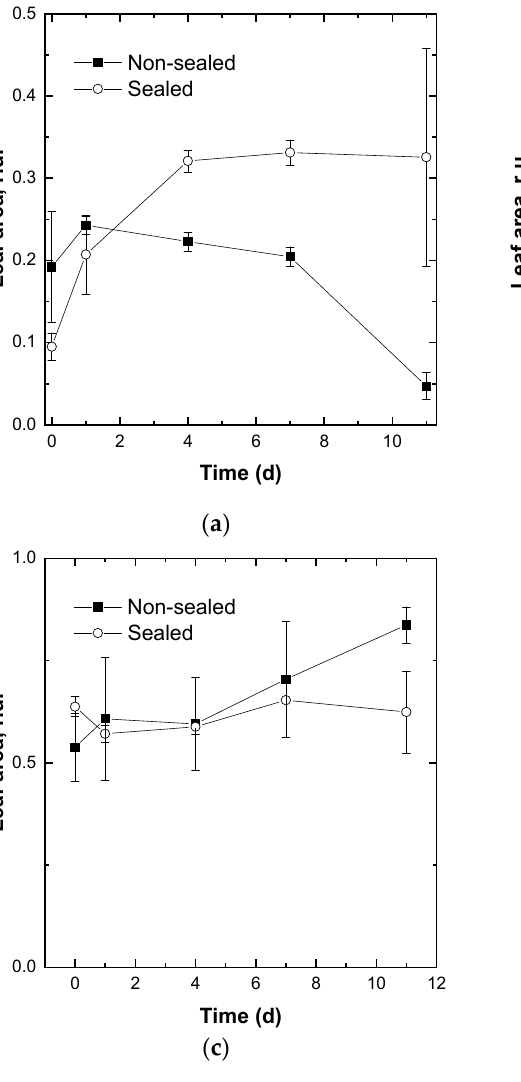
arbitrary chosen ranges according to the level of photosynthetic activity of the leaves [29]: